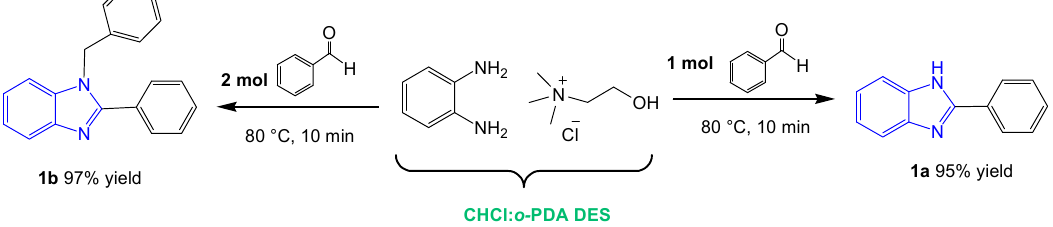
Table 3. Synthesis of 2-substituted benzimidazoles a